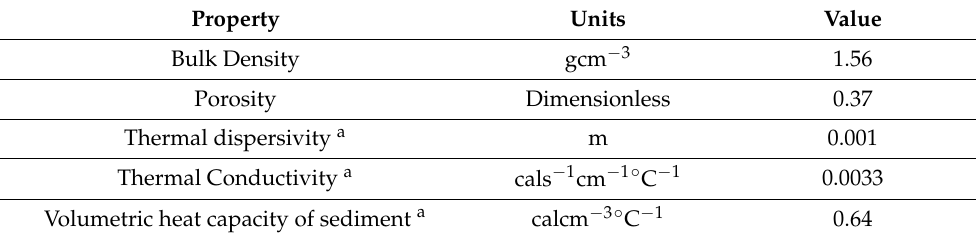
Table 1. Yellowstone River study area sediment